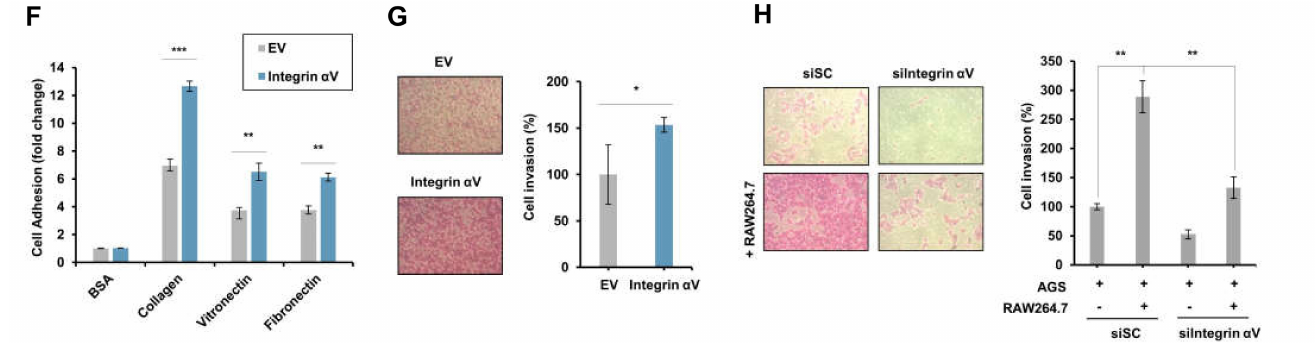
Figure 2. Integrin α V is involved in the invasion of AGS cells cocultured with RAW264.7 cells. ( A ) The effect of macrophages on the adhesion of gastric cancer cells. After coculture of AGS cells and RAW264.7 cells for 24 h, cell adhesion to the extracellular matrix (ECM)-coated plate was analyzed using sulforhodamine B (SRB) dye ( n = 3). ( B , C ) The effect of macrophages on the invasion of gastric cancer cells. After coculture of gastric cancer cells and RAW264.7 cells for 24 h, cell invasion was analyzed by SRB assay ( n = 3). ( D ) Integrin α V expression induced by coculture of RAW264.7 cells with AGS or NUGC3 cells. Integrin α V expression was analyzed by Western blotting (three replicates). ( E ) The expression of integrin α V in AGS cells transfected with pCMV3 − HA (empty vector) or pCMV3 − Integrin α V − GFP (two replicates). ( F , G ) The effect of integrin α V on adhesion ( F ) and invasion (G) of AGS cells ( n = 3). ( H ) The knockdown of integrin α V inhibited the increase in the invasion of gastric cancer cells induced by macrophages. After AGS cells were transfected with siScramble (SC) or siIntegrin α V for 24 h, the cells were incubated with RAW264.7 cells for 24 h. Cell invasion was analyzed using the SRB assay ( n = 3). Student’s t − test was used for statistical analyses. The bars indicate the S.D.; the asterisks denote significant differences (*** p < 0.001, ** p < 0.01, * p < 0.05) between the means of two